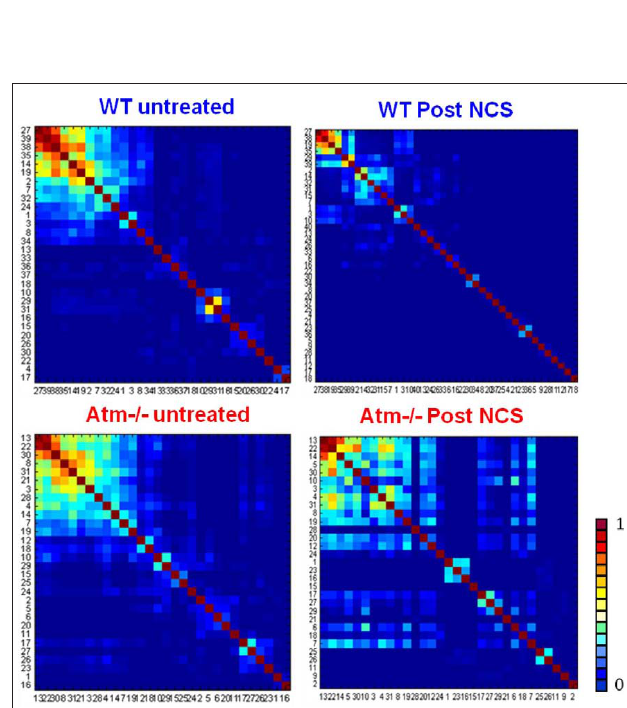
points are not evenly spaced in the [0,1] × [0,1] area, it is clear that the assumption that phase synchronization is unbiased by firing rate is supported by the recorded data and calculations.